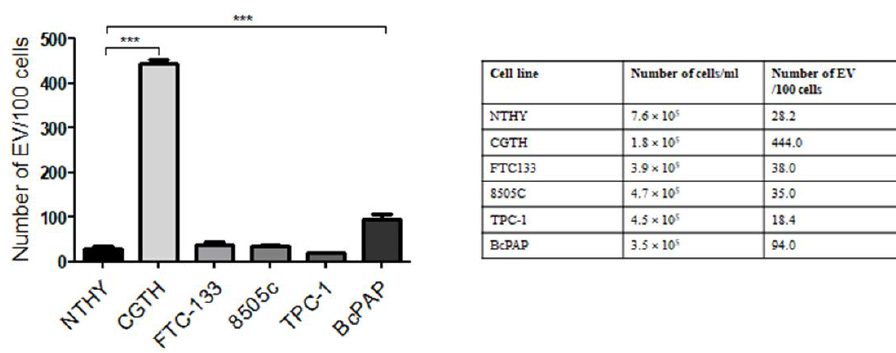
Figure 3. The average number of extracellular vesicles (EVs) released by thyroid cell lines per 100 cells. Data are shown as means with standard deviations (±SEM). ***: p < 0.001.